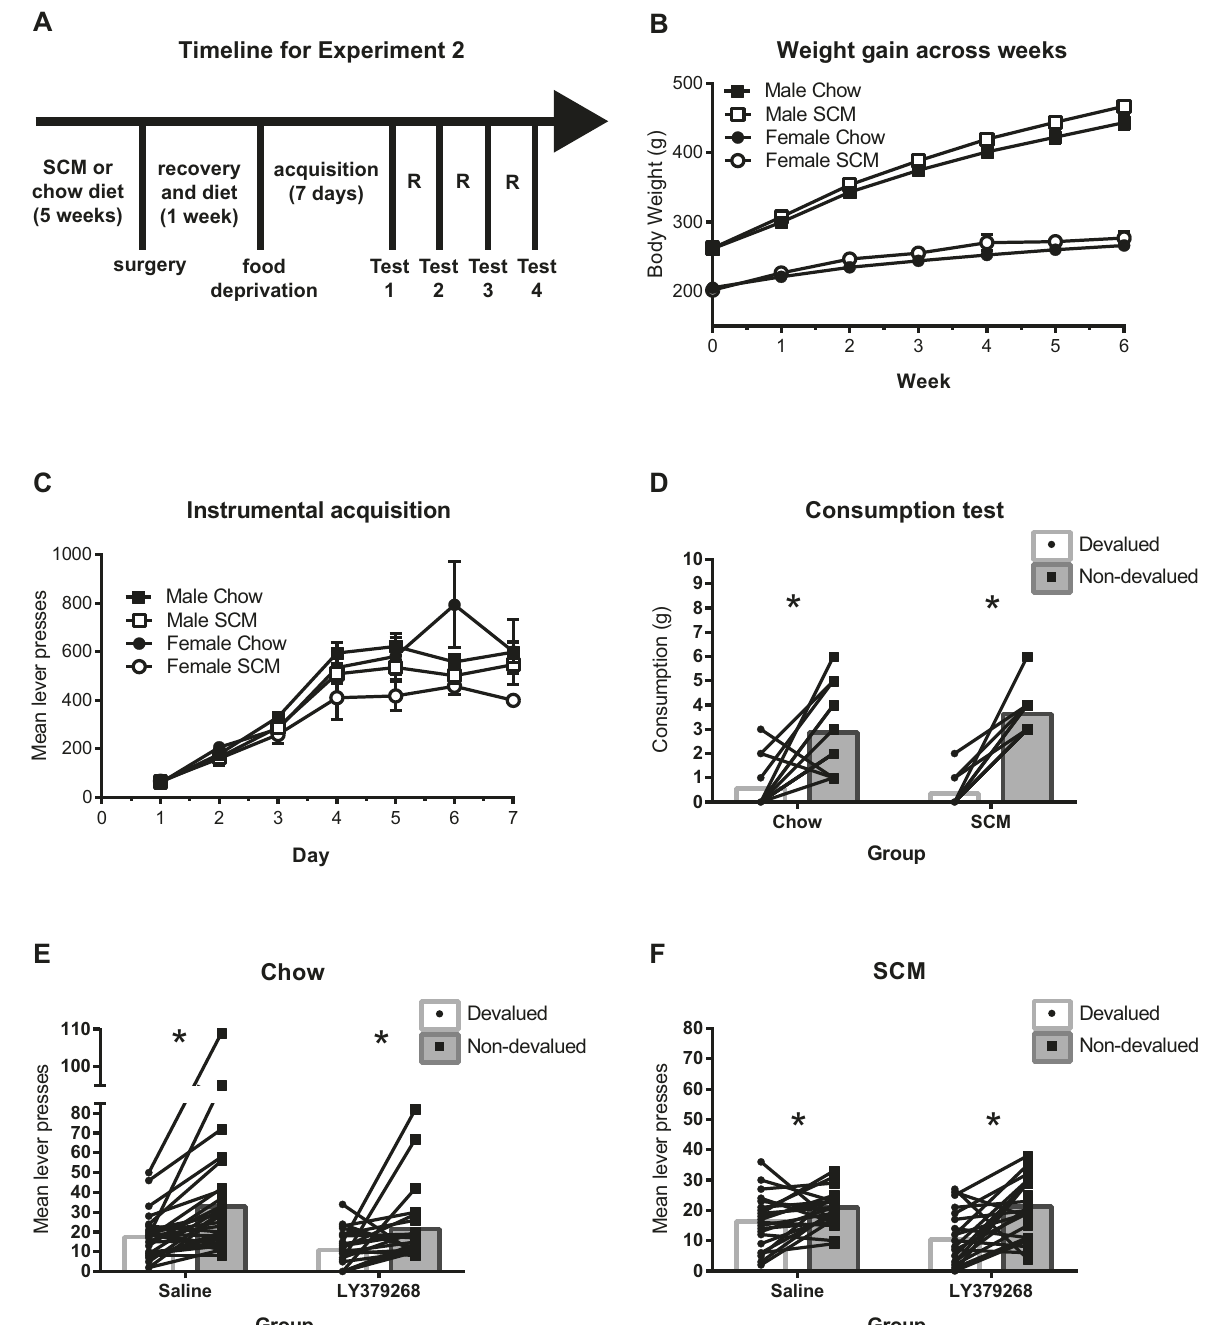
Fig. 4 mGluR2/3 agonism speci fi cally within the DMS is suf fi cient for restoring goal-directed control following long-term access to an obesogenic diet. A Experimental timeline for Experiment 2. B Weight gain. All rats gained weight across six weeks of SCM or Chow diets, while those in the SCM groups gained more than those receiving only chow and males gained more than females. Mean (SEM) body weight across weeks of diet exposure for male and female rats. C Instrumental acquisition. Mean (SEM) lever presses across days of instrumental training. Lever-press rates increased across days of training for all groups. D Consumption test of outcome devaluation. Chow and SCM groups both showed sensitivity to outcome devaluation as measured by consumption of a devalued versus nondevalued food verifying the ef fi cacy of the devaluation treatment itself in both groups. E Outcome-devaluation test: Chow group. Rats maintained on chow are sensitive to outcome devaluation and treatment with LY379268 reduces overall responding. F Outcome-devaluation test: SCM group. A history of access to an obesogenic diet reduces sensitivity to outcome devaluation. This de fi cit was ameliorated by mGluR2/3 agonism in the DMS. N = 29 for the Chow and 24 for the SCM groups, respectively. Across all fi gures, * indicate that p <